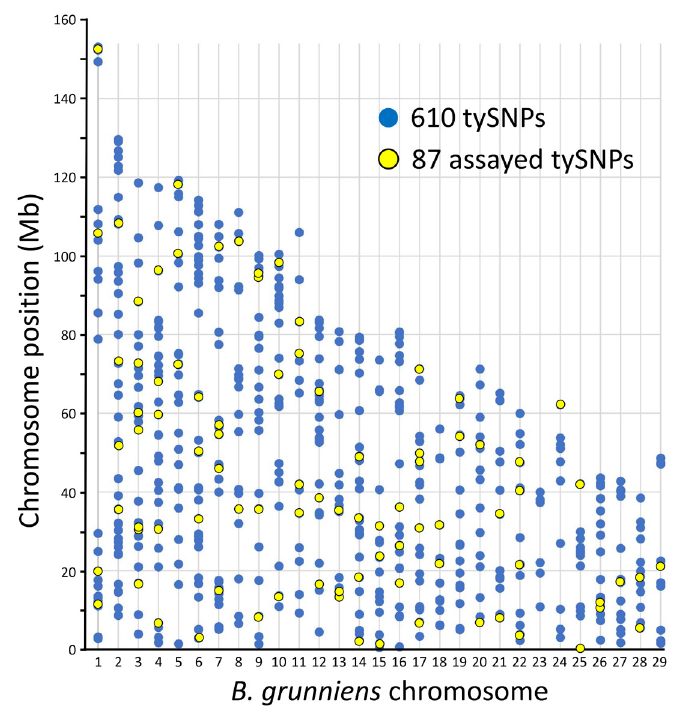
Figure 4. Chromosomal locations of tySNPs. The positions of 610 tySNPs are shown aligned to the ARS_UNL_BGru_maternal_1.0_p yak assembly. Yellow dots indicate those 87 tySNPs converted to assays and used in NA yak to estimate allele frequencies and utility. (Figure4_